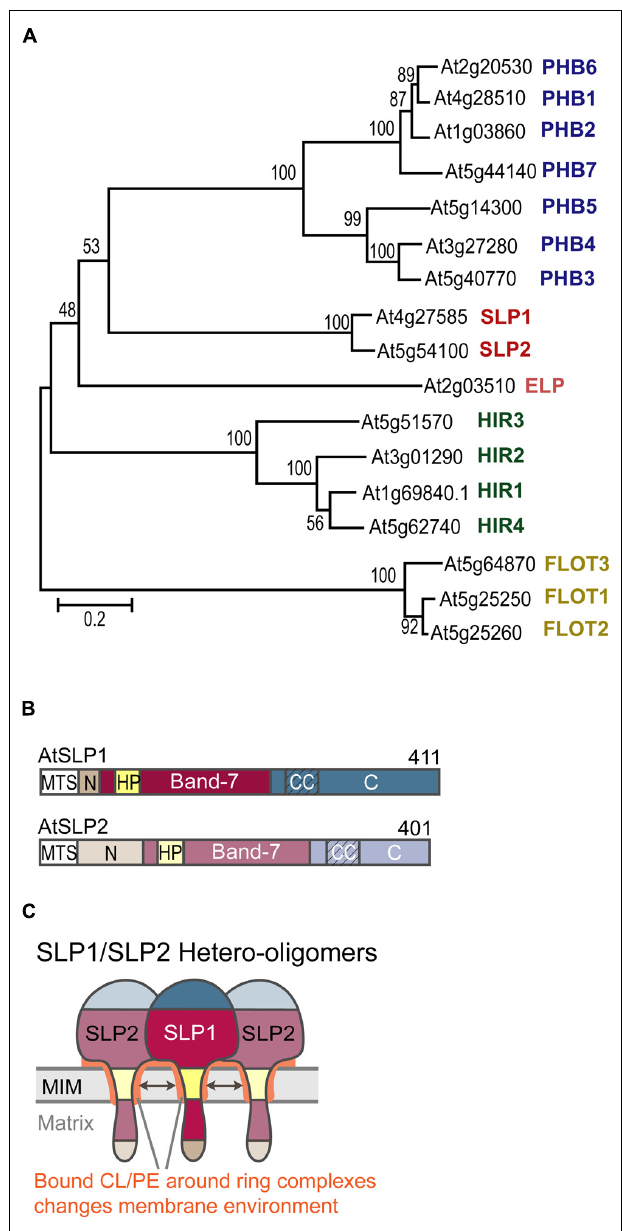
FIGURE 1 | Arabidopsis thaliana band-7 protein family members. (A) Phylogenetic bootstrap tree of the Arabidopsis band-7 protein family. PHBs (prohibitins) in blue, SLPs (stomatin-like proteins) in red, ELP (erlin-like protein) in pink, HIRs (hypersensitive response induced proteins) in green, FLOTs (flotillin-like proteins) in yellow. This tree was created by the neighborhood-joining method. Reprinted with permission by ASPB. (B) Schematic of AtSLP domains. MTS (mitochondrial targeting sequence), N (N-terminal domain), HP (hydrophobic patch), Band-7 (band-7 domain), CC (predicted coiled-coil regions), C (C-terminal domain). (C) Schematic of SLP1-SLP2 hetero-oligomers embedded within the mitochondrial inner membrane. Coloring corresponds to the scheme in B . Cardiolipin-binding to SLP oligomers is indicated by the orange color around the hydrophobic patches and between the inner membrane and the band-7